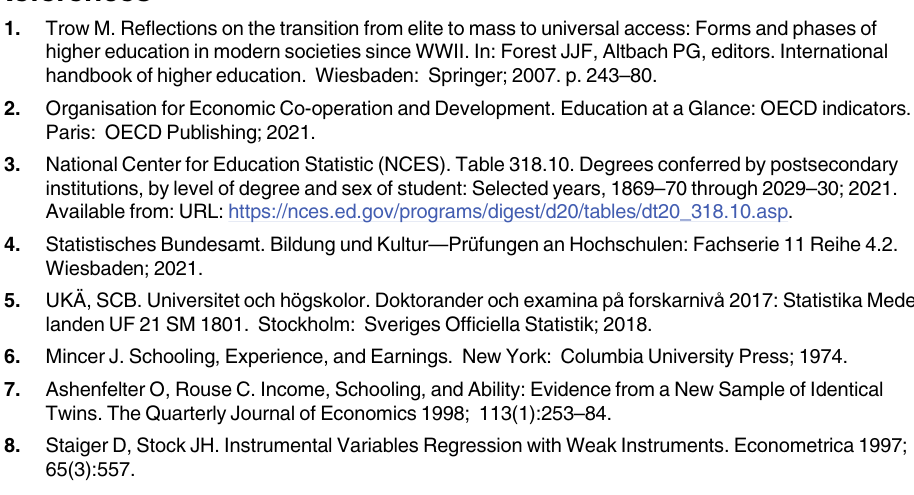
S1 Table. Description of variables. S2 Table. Summary statistic. S3 Table. Subsample analysis for doctorate recipients working at university or non-univer- sity research institute. S4 Table. Robustness analysis for additional push and pull factors for staying in academia after